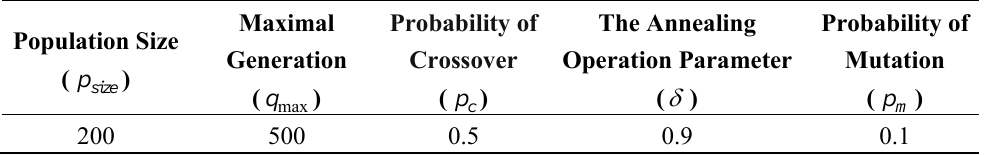
Table 3. CIA’s parameters setting.